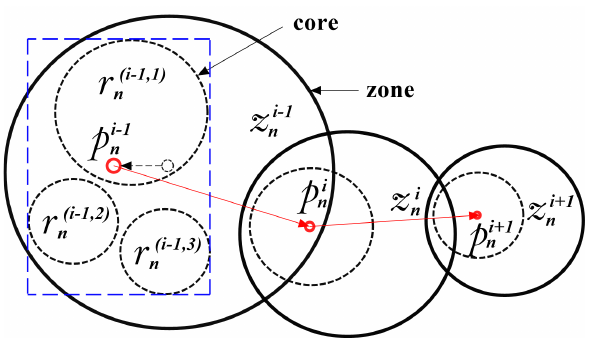
Figure 5. Shift the center of mass of the zone to the centroid of the minimum enclosing rectangle of all the